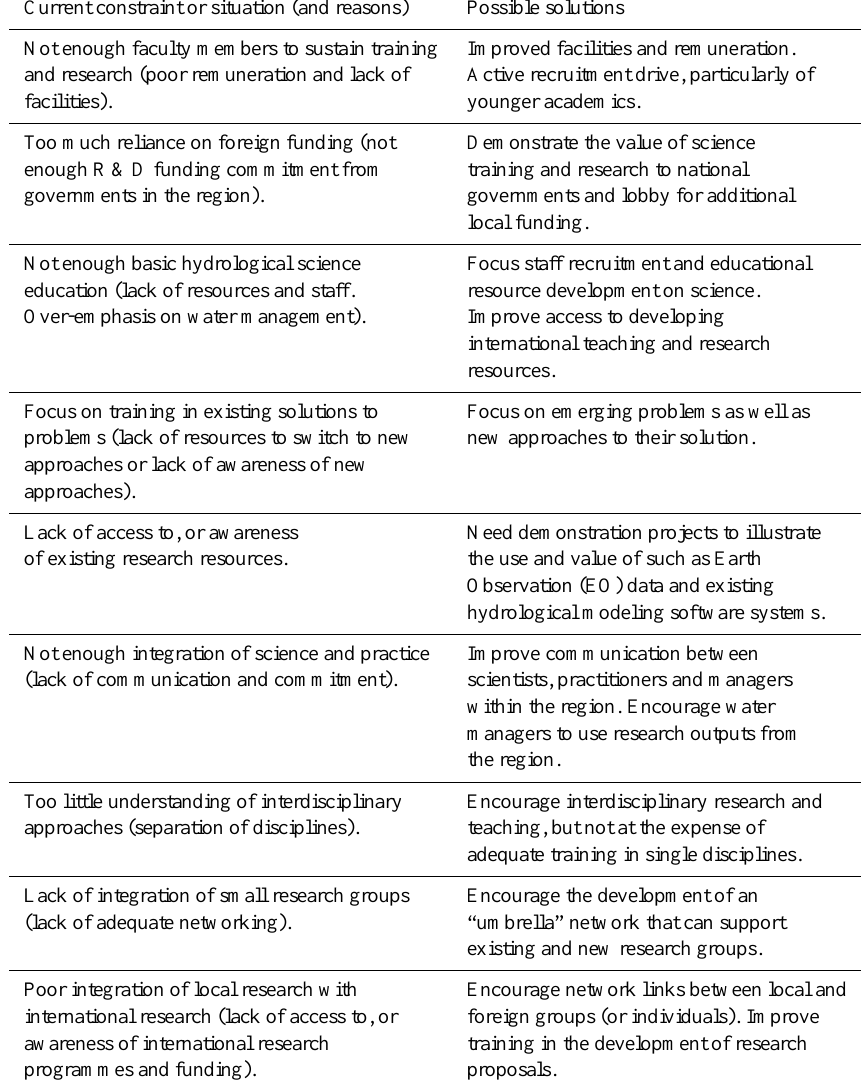
Table 1. Summary of current constraints and possible ways forward (note that there will be overlaps between the constraints and